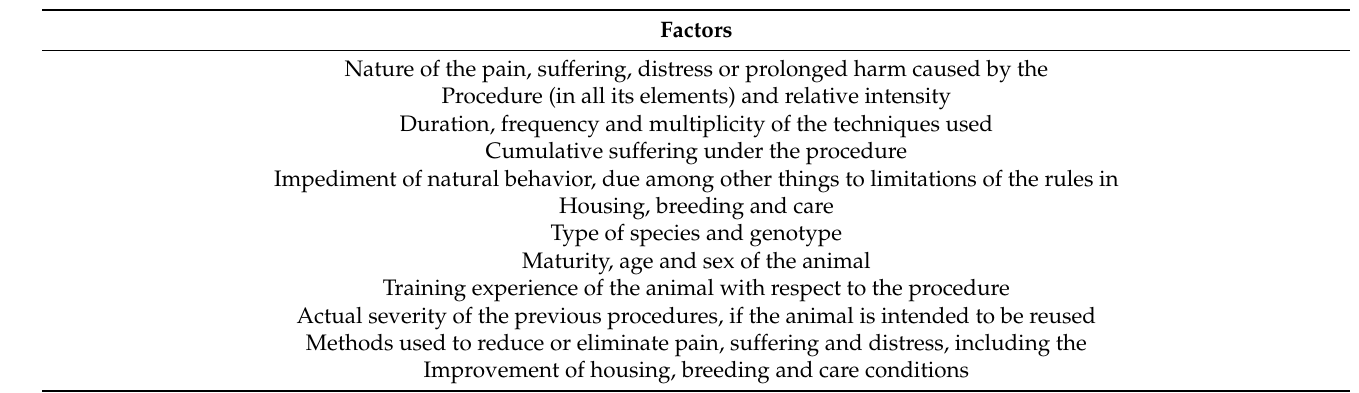
Table 3. Factors related to the procedure.